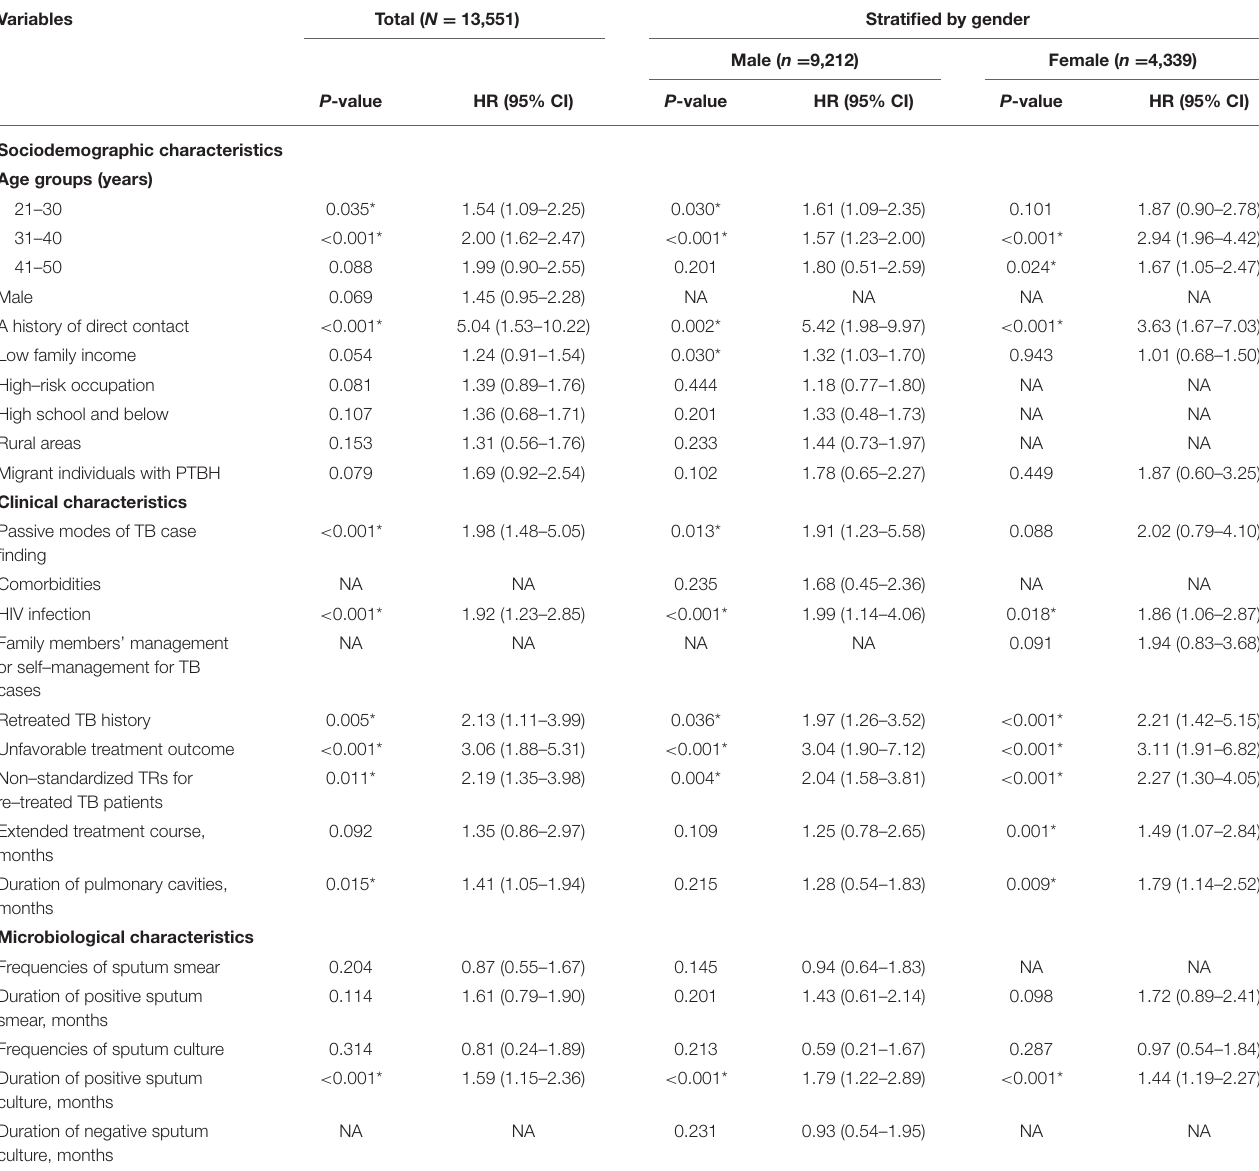
TABLE 5 | Multivariate Cox regression analysis of risk factors of MDR-TB among individuals with PTBH in Hangzhou, China.